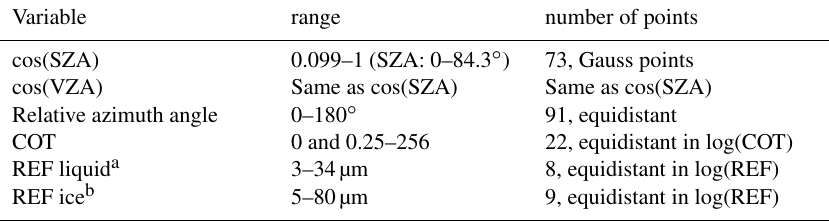
Table 1. Specification for the LUTs created with DAK. Discrete values are given for all variables spanning the axes of the LUTs. Variable range number of